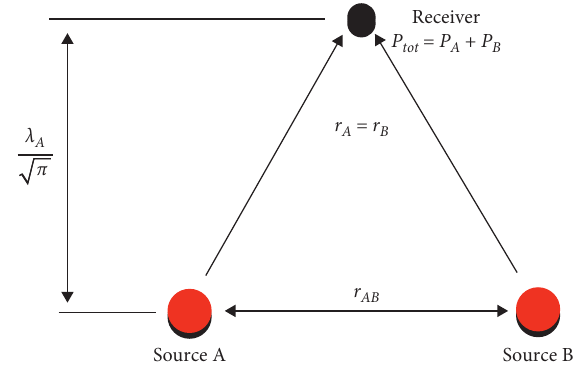
Figure 2: The general setup of two sources and the